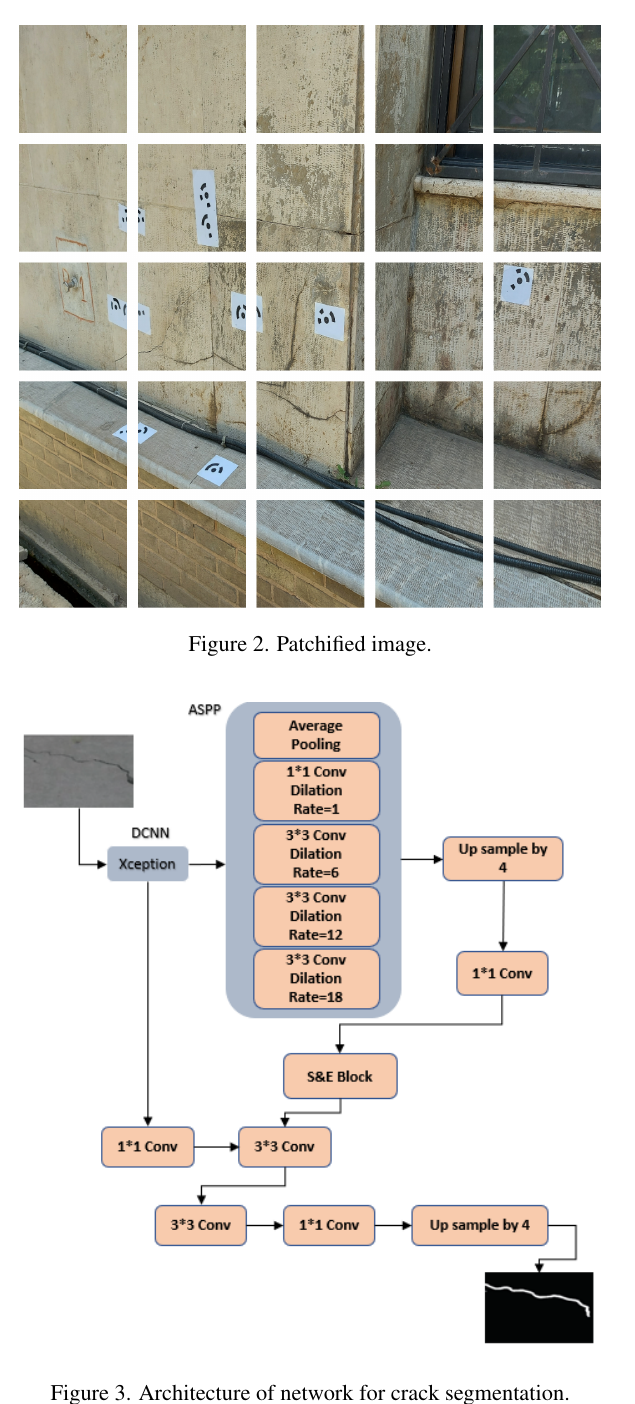
Figure 3. Architecture of network for crack segmentation.